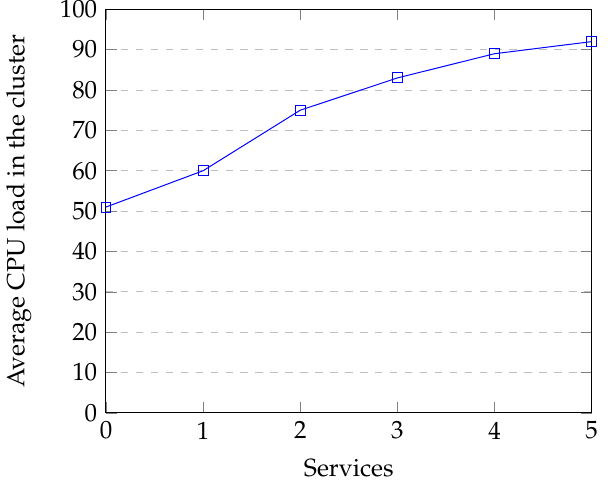
Figure 7. Average CPU load in the cluster upon introduction of services.